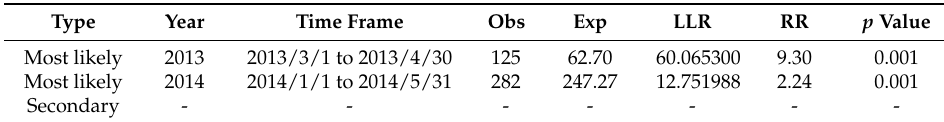
Table 2. The temporal clusters of influenza A(H7N9) cases detected using the temporal cluster analysis, China,